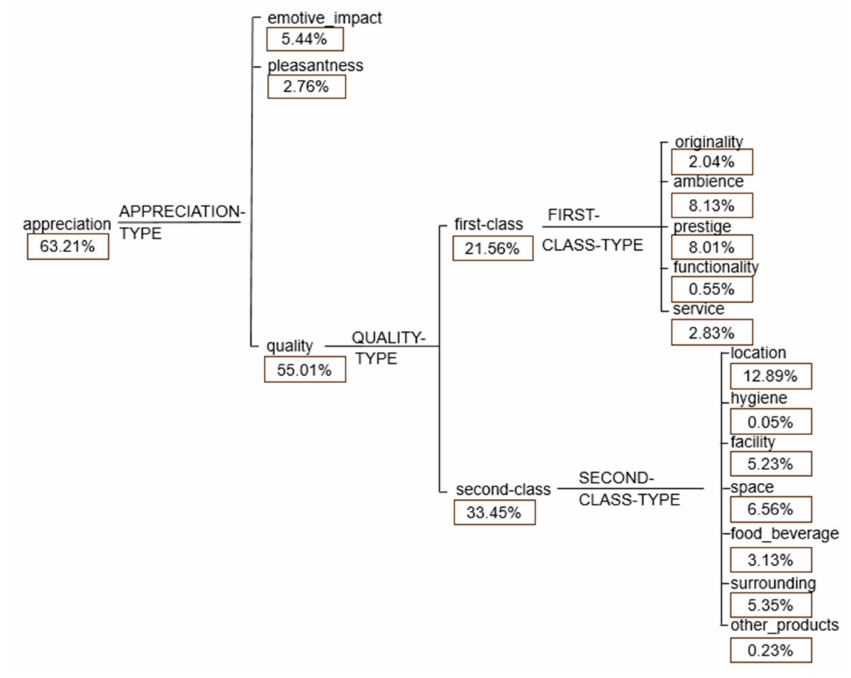
Figure 2. Use of appreciation resources in the